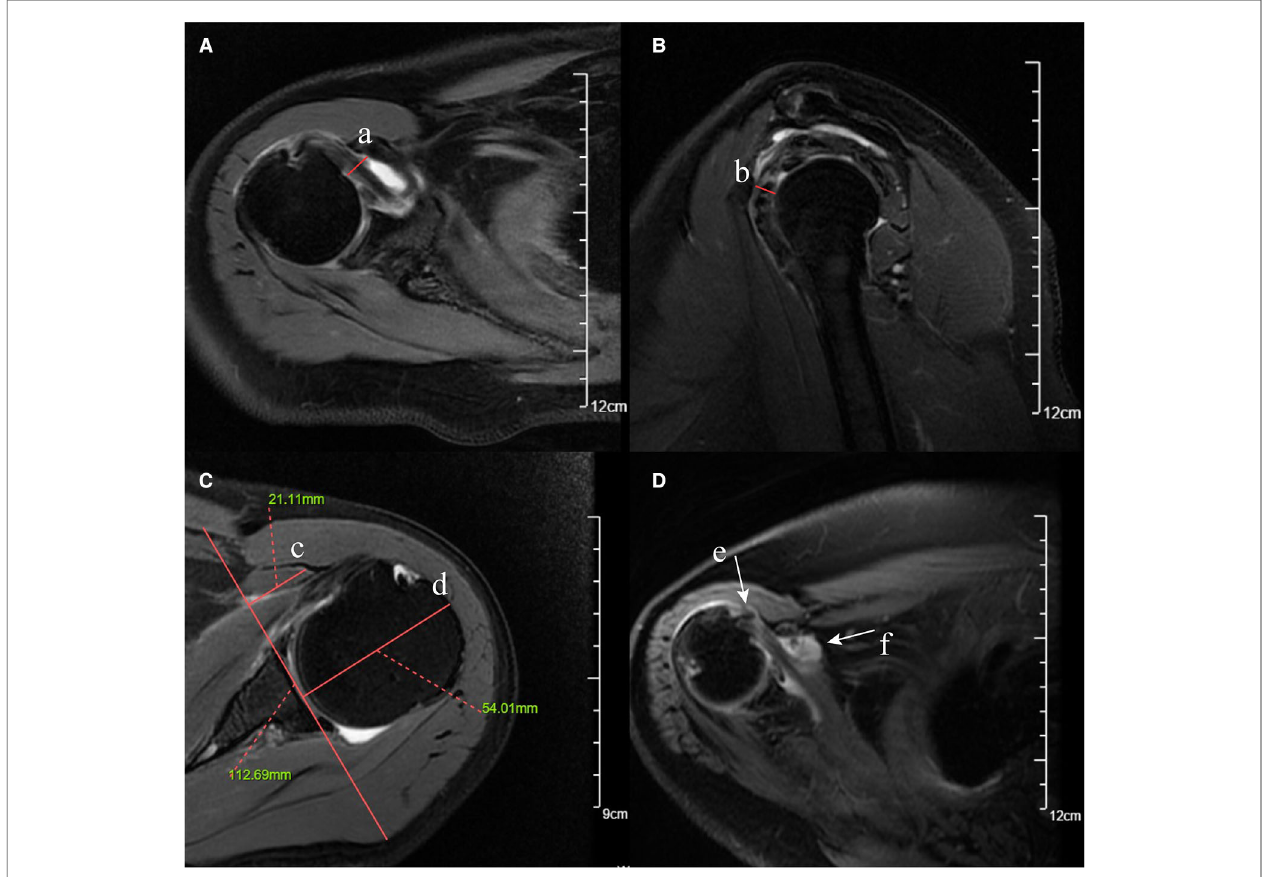
FIGURE 1 | Fat-suppressed T2-weighted MRI images of coracohumeral distance (CHD), coracoid overlap (CO), coracohumeral index (CHI), LHB malposition, and subcoracoid effusion. ( A ) CHD measured on the axial plane (red solid line a). ( B ) CHD measured on the oblique sagittal plane (red solid line b). ( C ) CO (red solid line c) and CHI (red solid line c/ red solid line d, 21.11 mm/54.01 mm). ( D ) LHB malposition on the axial plane (white arrow e). ( E ) Subcoracoid effusion on the axial plane (white arrow